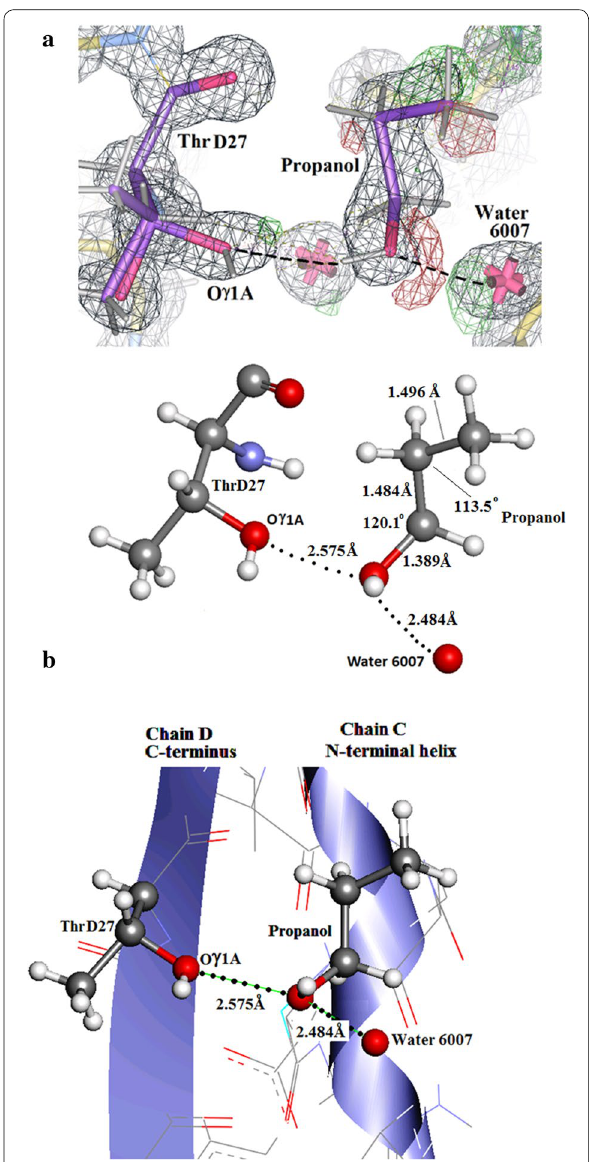
Fig. 17 a Insugen (I) COOT electron density in the vicinity of ThrD27. Electron density for the solvated propanol 5001 and water 6007 are shown. H‑bonds between propanol and Oγ1A of ThrD27 and water 6007, respectively are indicated. Drawn with WinCoot 0.7 [19]. b Detail produced by Discovery Studio 3 (Accelerys) [23, 35] showing the solvated propanol in Insugen (I) with respect to OG1A ThrD 27 and water 6007. c The solvated propanol in Insugen (I) with respect to Oγ1A Thr D27 and water 6007. Drawn with Discovery Studio 3 (Accelerys) [23, 35]